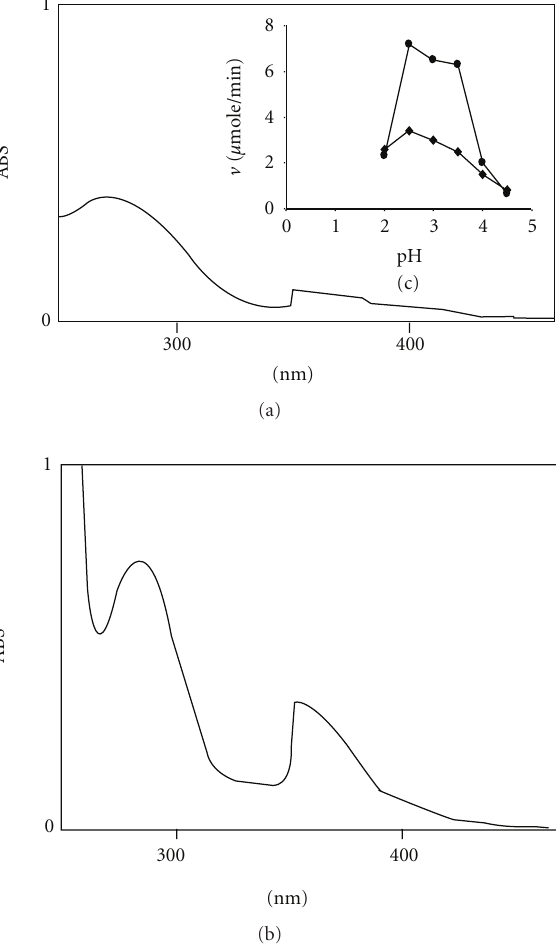
Figure 6: Spectra of the purified MnP catalysed oxidation of bromide and iodide as measured by the formation of (a) tribromide and (b) triiodide complexes. The pH dependence of Br − and I − oxidation by the purified enzyme is shown as insert (c). Reaction solution 1mL contained “2.5 μ g of the enzyme and 20 mM KBr (a) 0.5 μ g of the enzyme and 20 mM of KI in (b) in 20 μ M sodium succinate bu ff er pH 3.0 at 30 ◦ C containing 100 μ M H 2 O 2 .” In (c) the same solution compositions have been used as (a) and (b) but the pHs have been